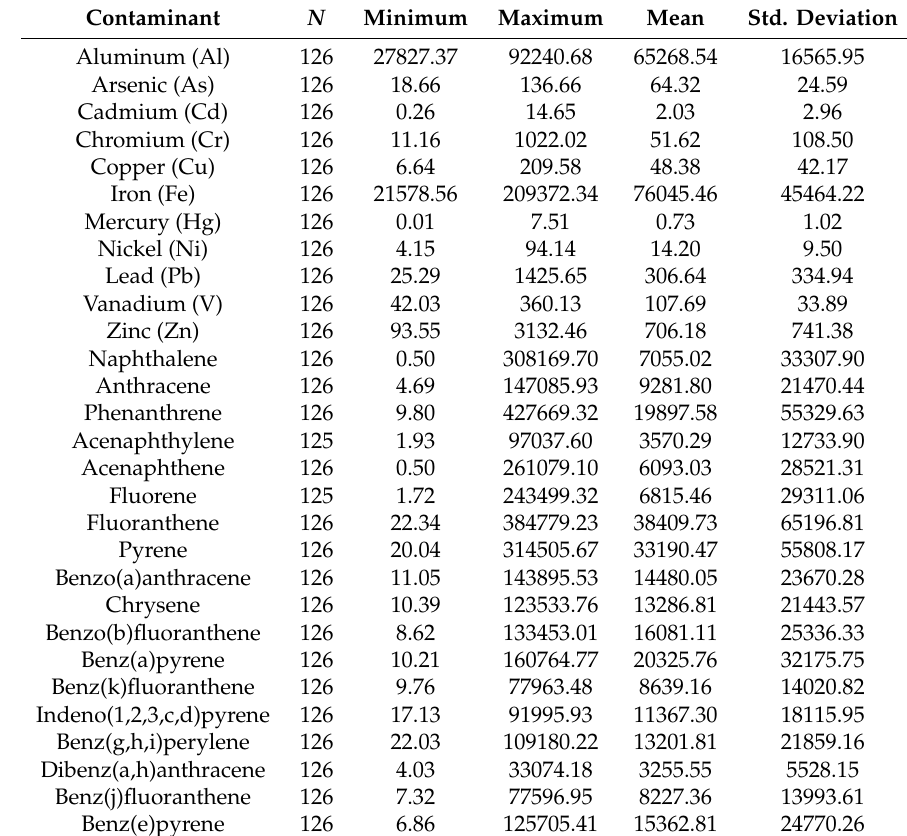
Table 1. General statistics of the sampled contaminants in Bagnoli sea sediments. Heavy metals (in mg / kg) and polycyclic aromatic hydrocarbons (PAHs, in µ g / kg) are divided by bold